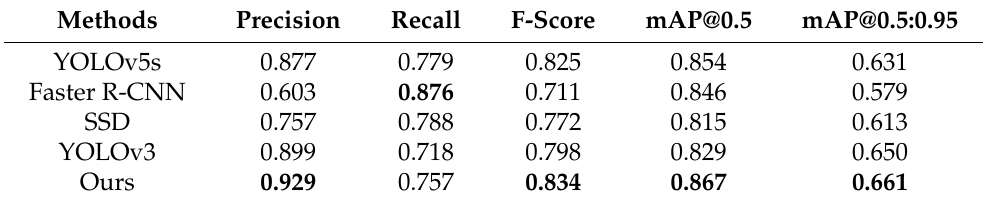
Table 1. Performance of hazardous material vehicles detection between different algorithms. (The optional value of each index is